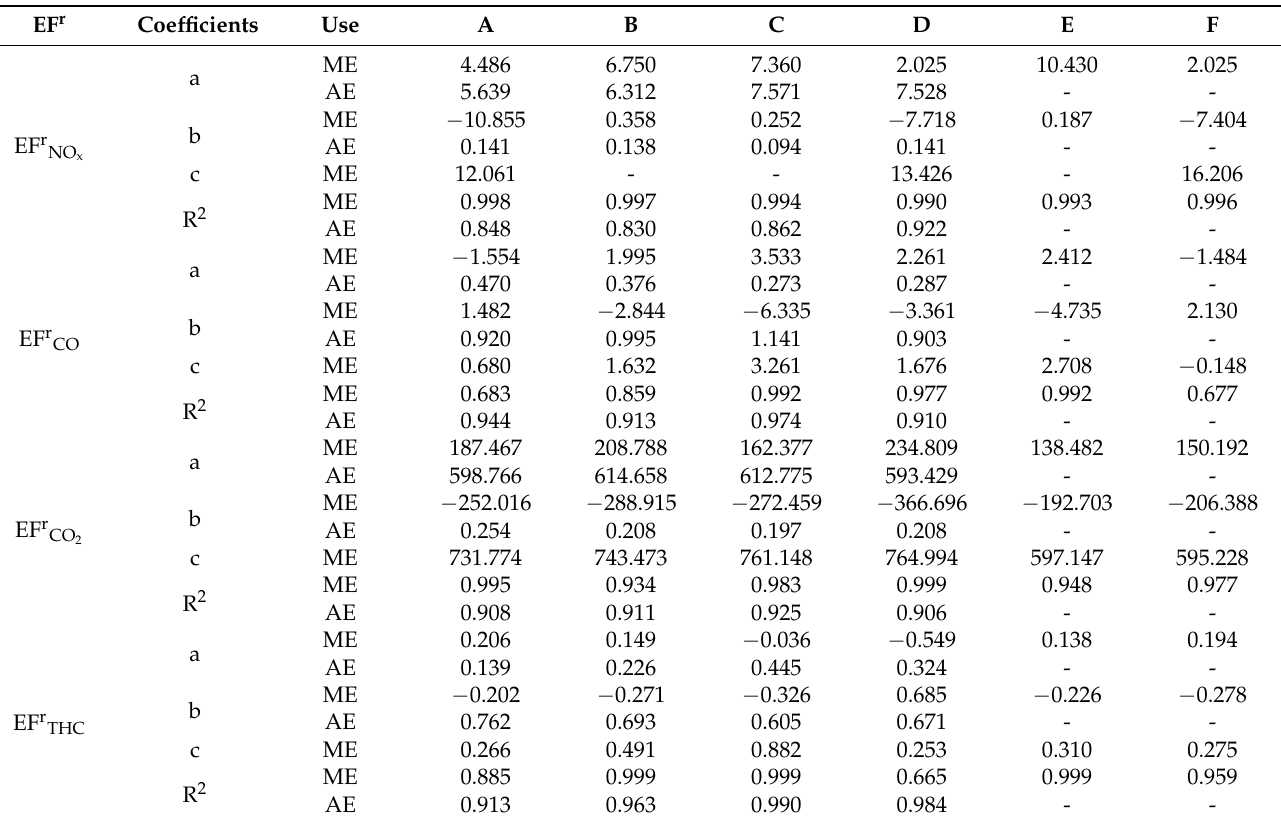
Table 4. Coefficients of fitting formulas for energy-based emission factors (g/kW